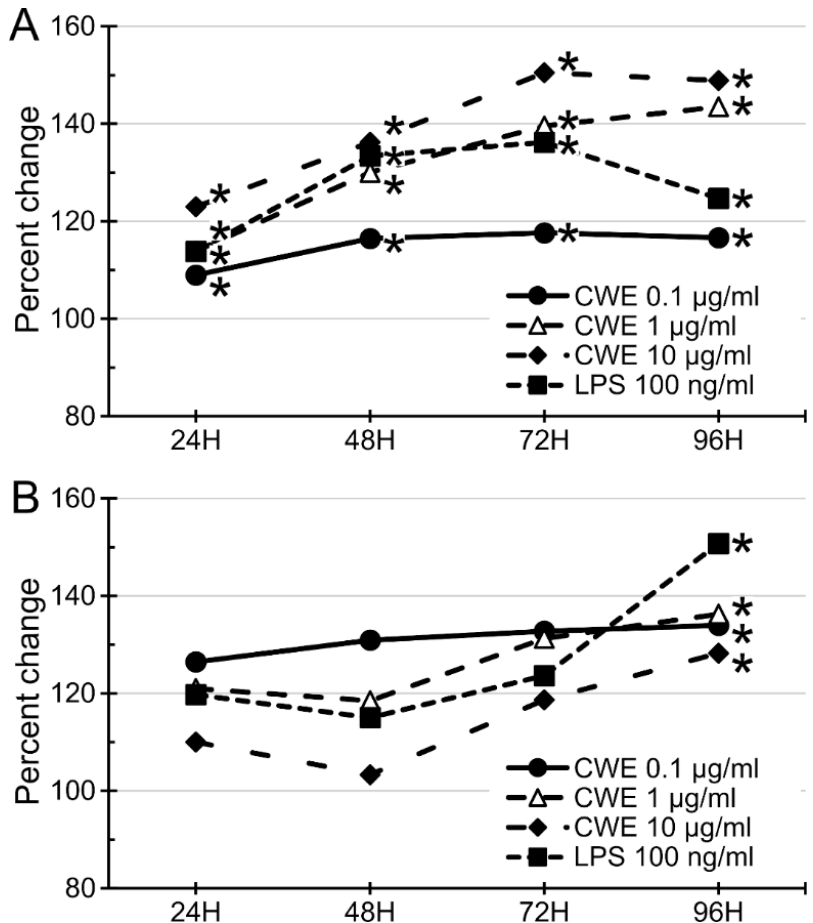
Figure 3. CWE dose- and time-dependently stimulated the growth of murine bone marrow cells (BMCs) and splenocytes (SPLs) in cell culture. CWE treatment dose-dependently (0.1 – 10 µg/mL) and time-dependently (24, 48 72 and 96 h) stimulated the growth of mouse BMCs ( A ) but not SPLs ( B ), 100 ng/mL LPS served as a positive control. The cell growth was evaluated by MTT (3-(4,5-dimethylthiazol-2-yl)-2,5-diphenyltetrazolium bromide) assay. The data was shown as percent change compared with phosphate buffered saline (PBS)-treated control. *, p < 0.05 compared to PBS-treated control ( n = 3).